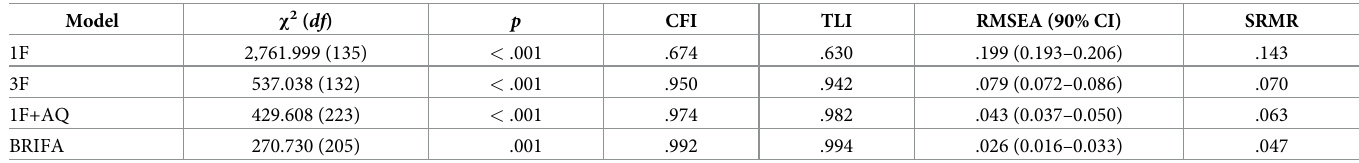
Table 3. Goodness of fit indices for the competing models.